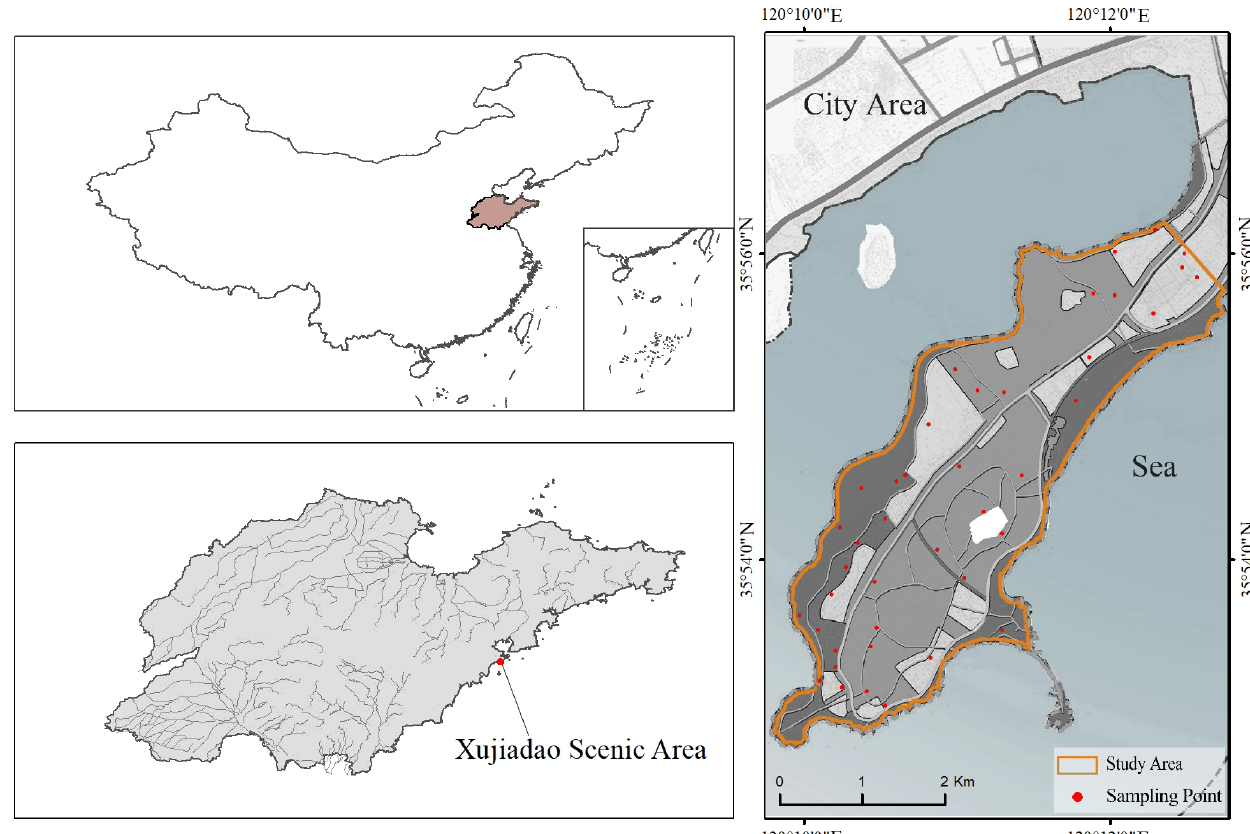
Figure 1. The sketch map of